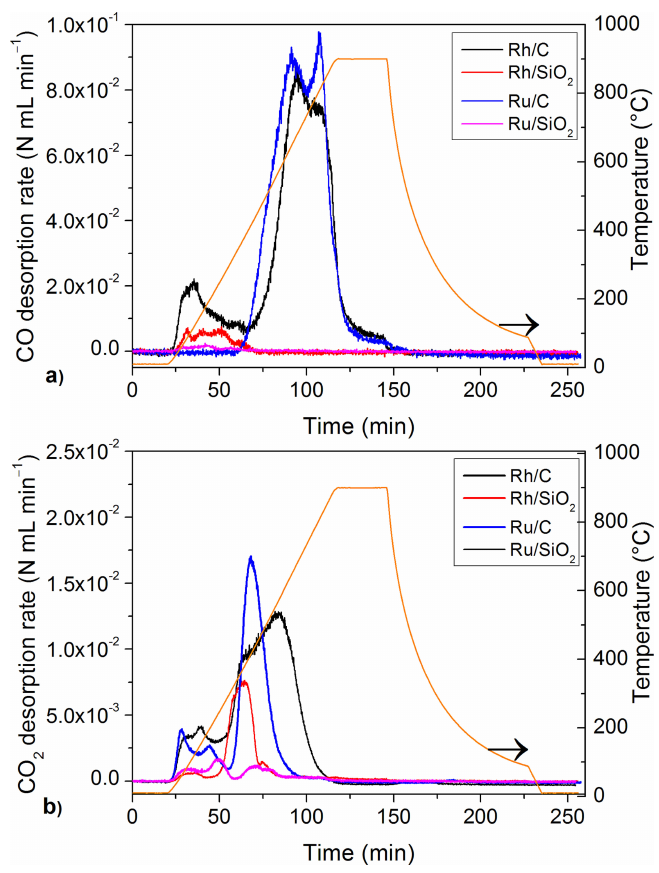
Figure 1. CO ( a ) and CO 2 ( b ) desorption rates of the supported Ru- and Rh-based catalysts during